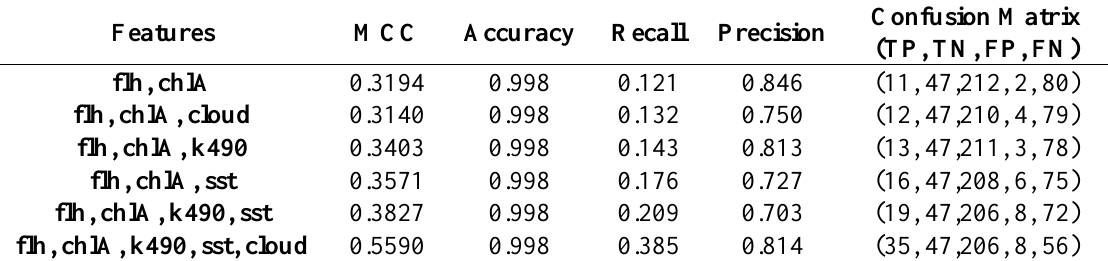
Table 1. Test results based on SVM.